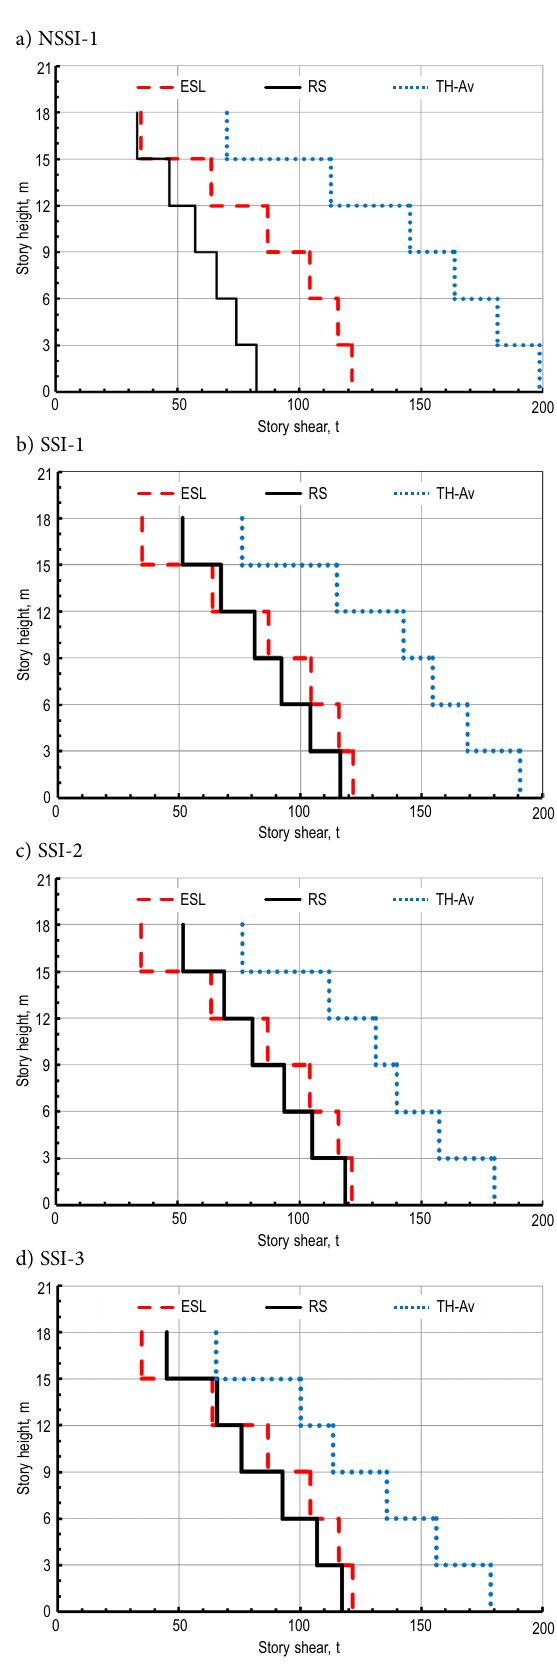
Fig. 12. Story shear force response of 6-story